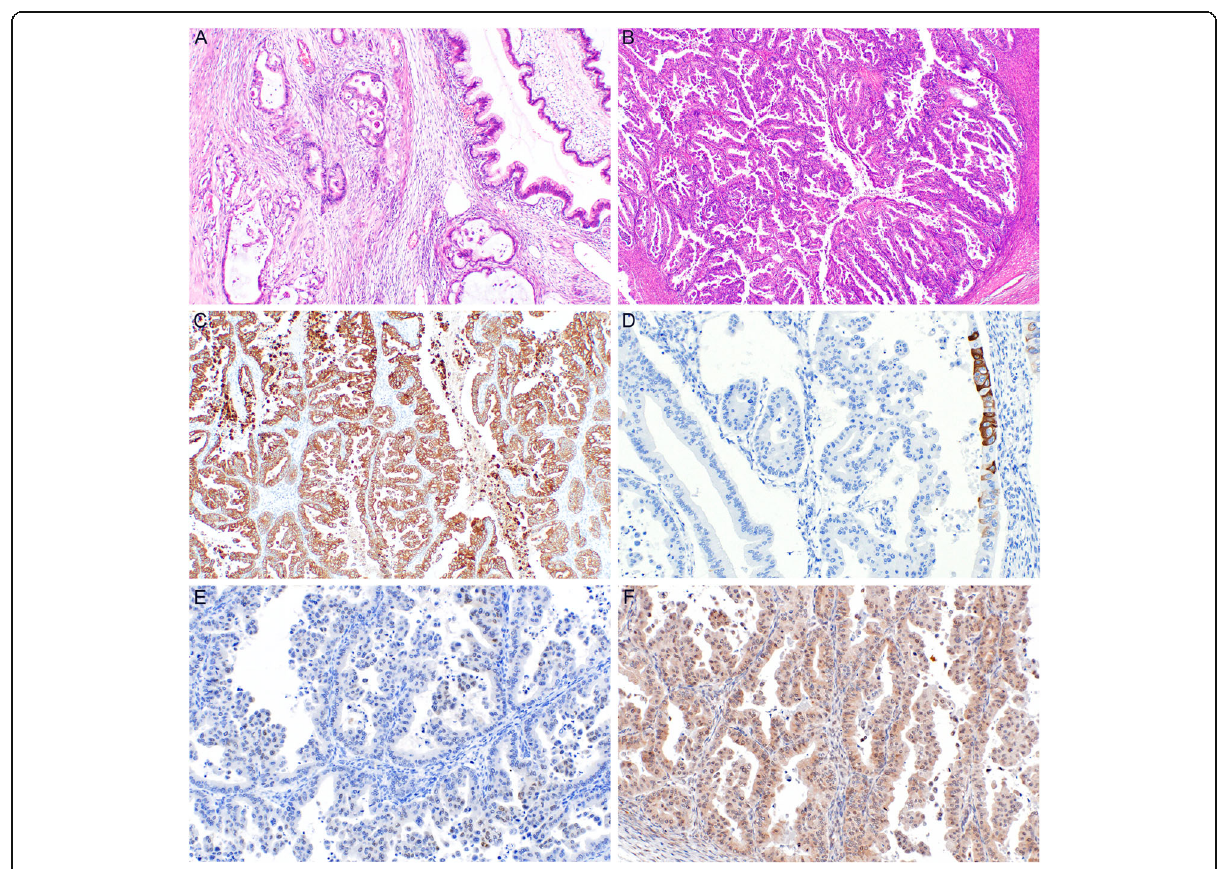
Fig. 2 Mucinous carcinoma of the ovary (MC). Infiltrative type of invasion with glandular and cribriform areas ( a ) (H&E, 100x). Expansile type of invasion with areas of complex glandular proliferation ( b ) (H&E, 40x). Diffuse expression of cytokeratin 7 ( c ) (100x) and focal expression of cytokeratin 20 ( d ) (200x). Focal and weak expression of PAX8 ( e ) (200x). Tumor cells showing retained expression of DPC4 ( f )